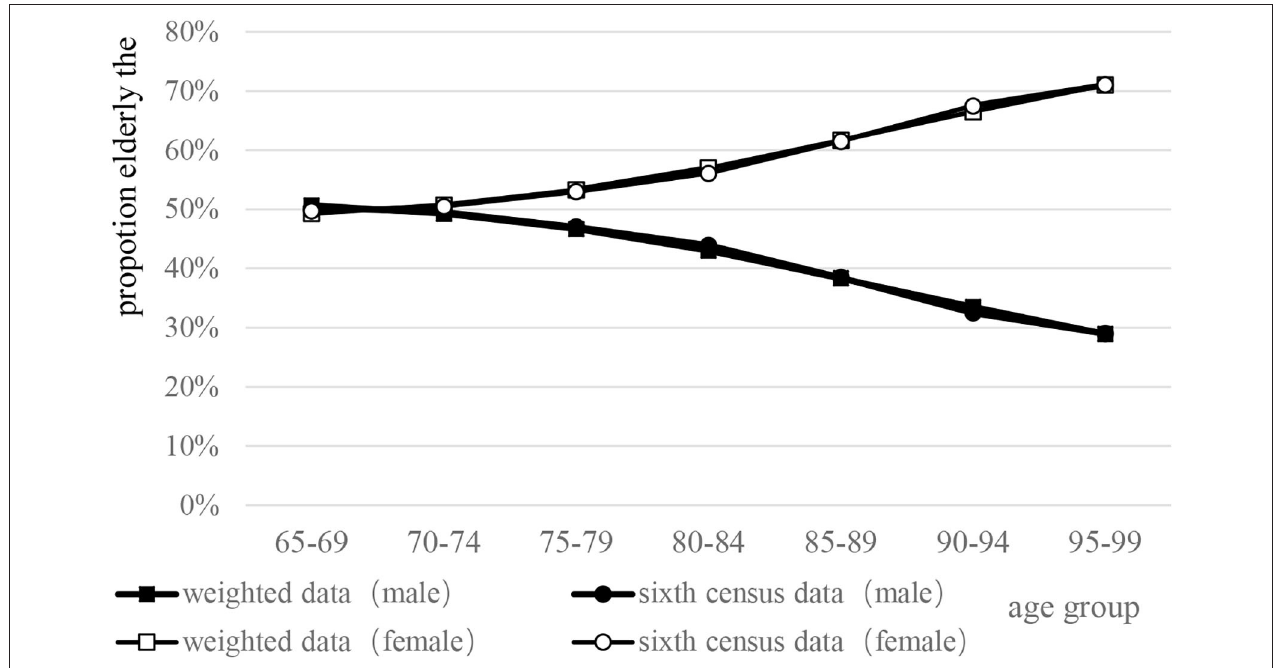
FIGURE 1 | Comparison between the sixth census data of China and weighted survey data by sex–age